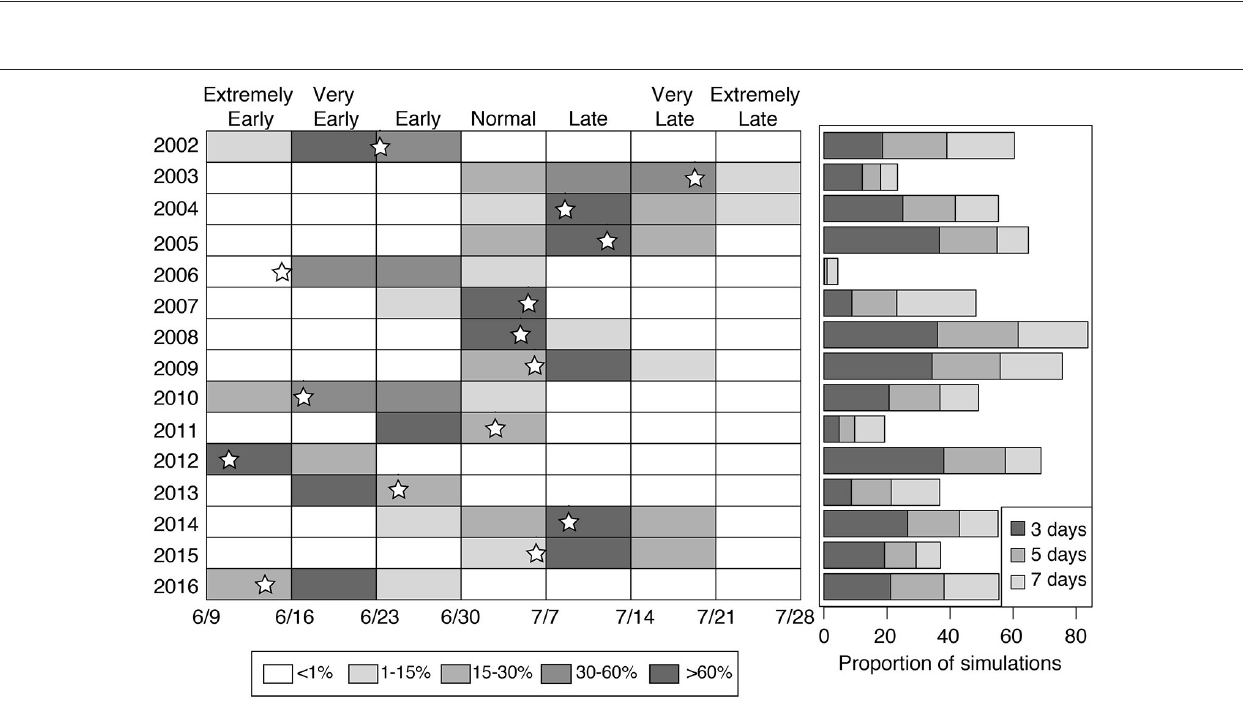
Frontiers in Marine Science | www.frontiersin.org